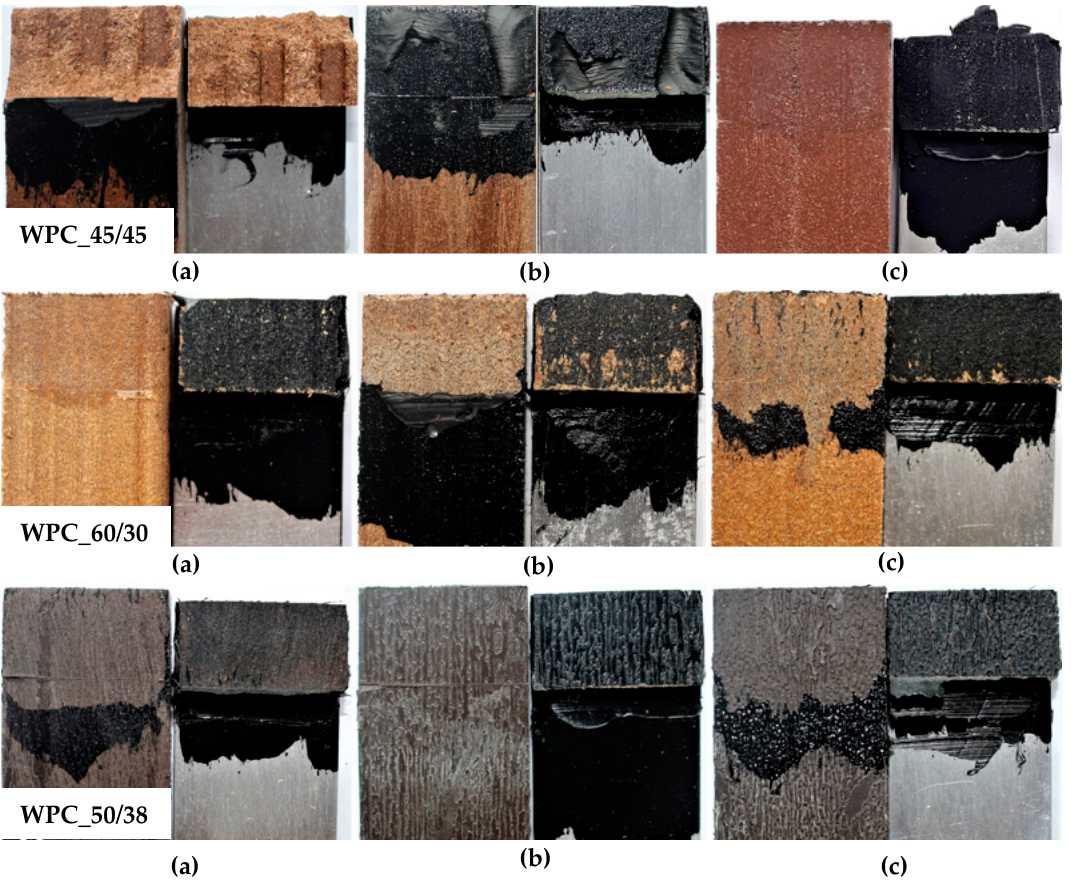
Figure 6. Typical failure mode of test samples after shear test: WPC_45/45 ( a ) sample with primer, plasma treatment (100% SF); ( b ) sample with primer, mechanical treatment (74% AF; 26% CF); ( c ) sample without primer, chemical treatment (100% AF); WPC_60/30 ( a ) sample without primer, plasma treatment (100% AF); ( b ) sample with primer, mechanical treatment (100% AF); ( c ) sample with primer, chemical treatment (100% AF); WPC_50/38 ( a ) sample with primer, mechanical treatment (100% AF); ( b ) sample without primer, chemical treatment (100% AF); ( c ) sample with primer plasma treatment (100% AF).